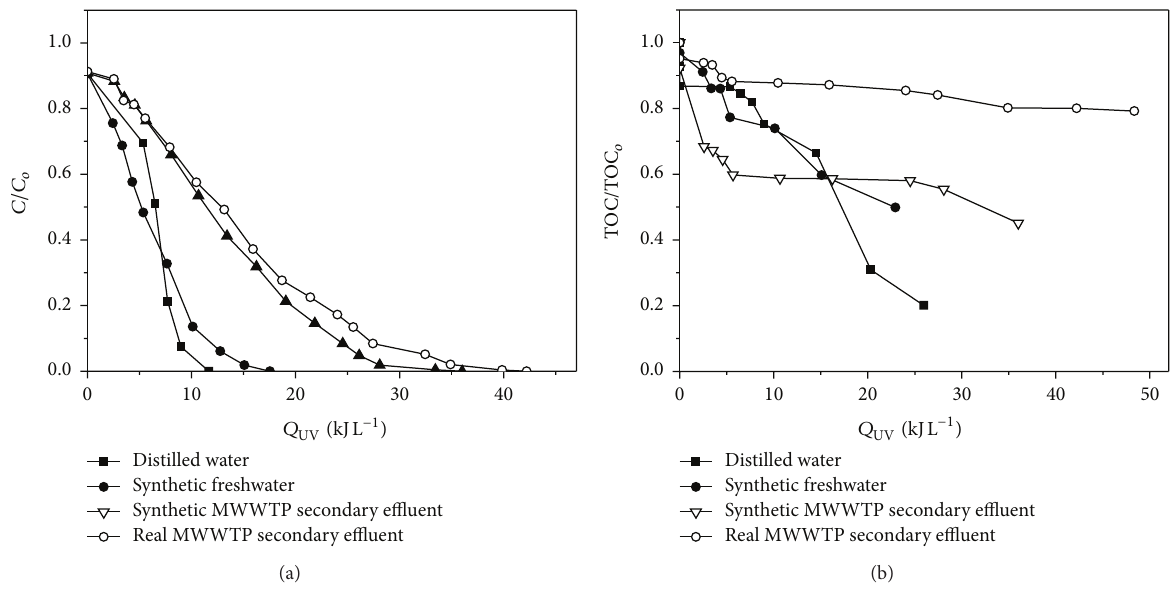
Figure 8: Solar CPC photodegradation of 30 mgL −1 of IC for different water matrices mediated TiO 2 supported on glass spheres: (a) IC concentration and (b) TOC